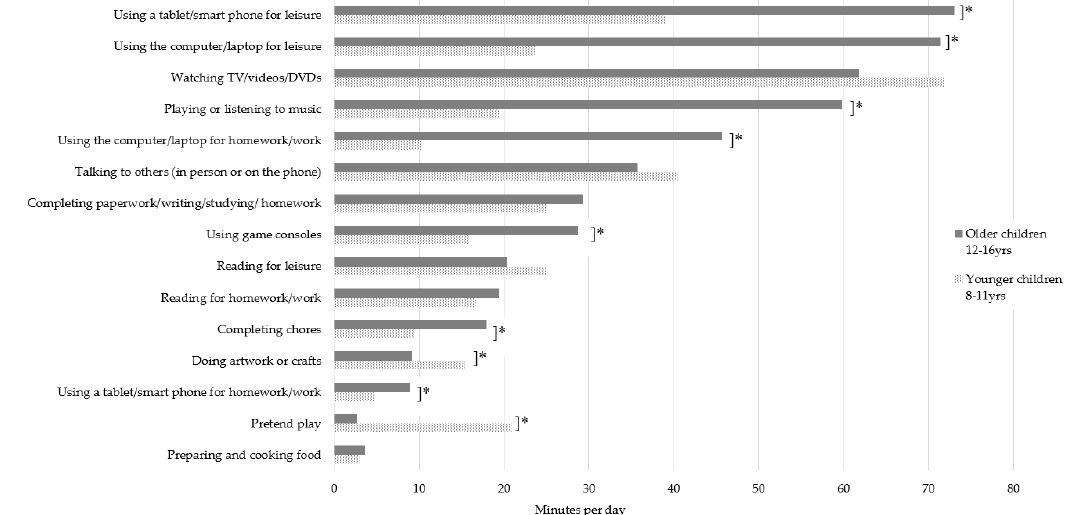
Figure 2. Total duration (minutes/day) of children’s home -based sitting behaviours by sex group. * Significant differences between older and younger children determined by independent samples t -tests, p < 0.05.